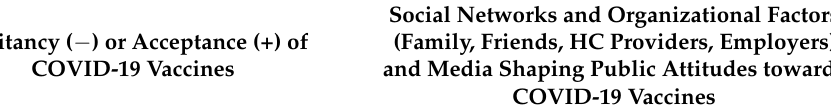
Table 5. Social and organizational factors associated with hesitancy or acceptance of COVID-19